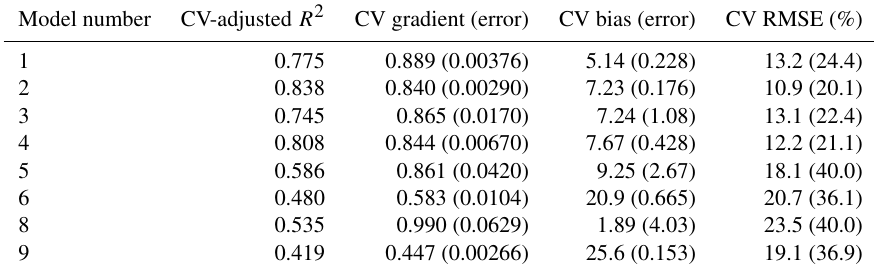
Table 4. The results of the 5-fold cross-validation (CV) applied to all the LUR models described in Table 2. Surface concentrations estimated using CV were compared against the original in situ measurements using linear regression, from which the adjusted R 2 , gradient, bias, and RMSE (µgm − 3 ) are derived. The standard error of the gradient and bias are also displayed, while the RMSE is also expressed as a percentage of the mean concentration estimated by the